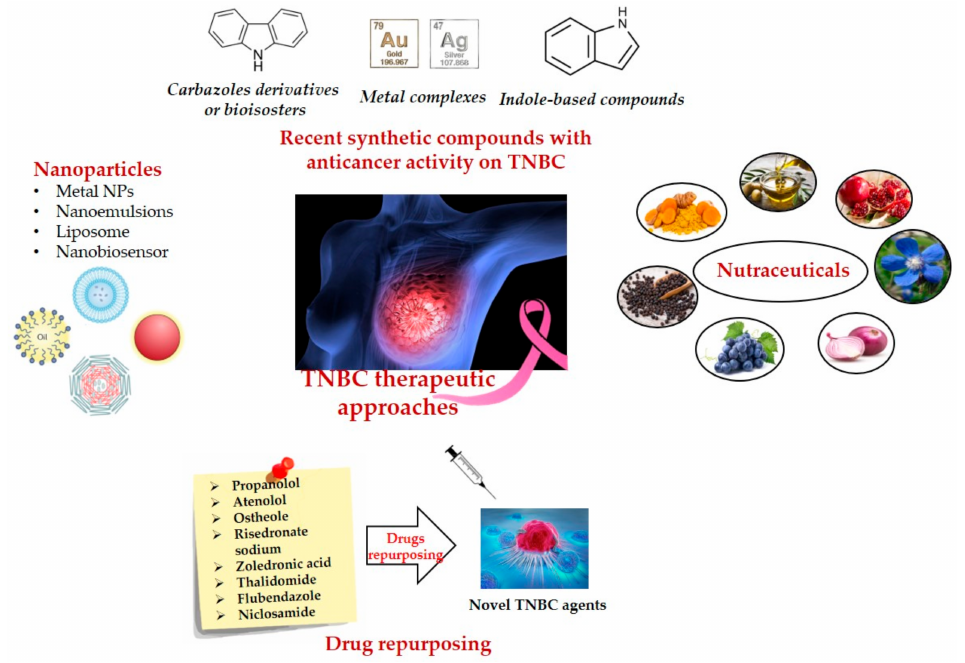
Figure 2. Novel therapeutic approaches for TNBC